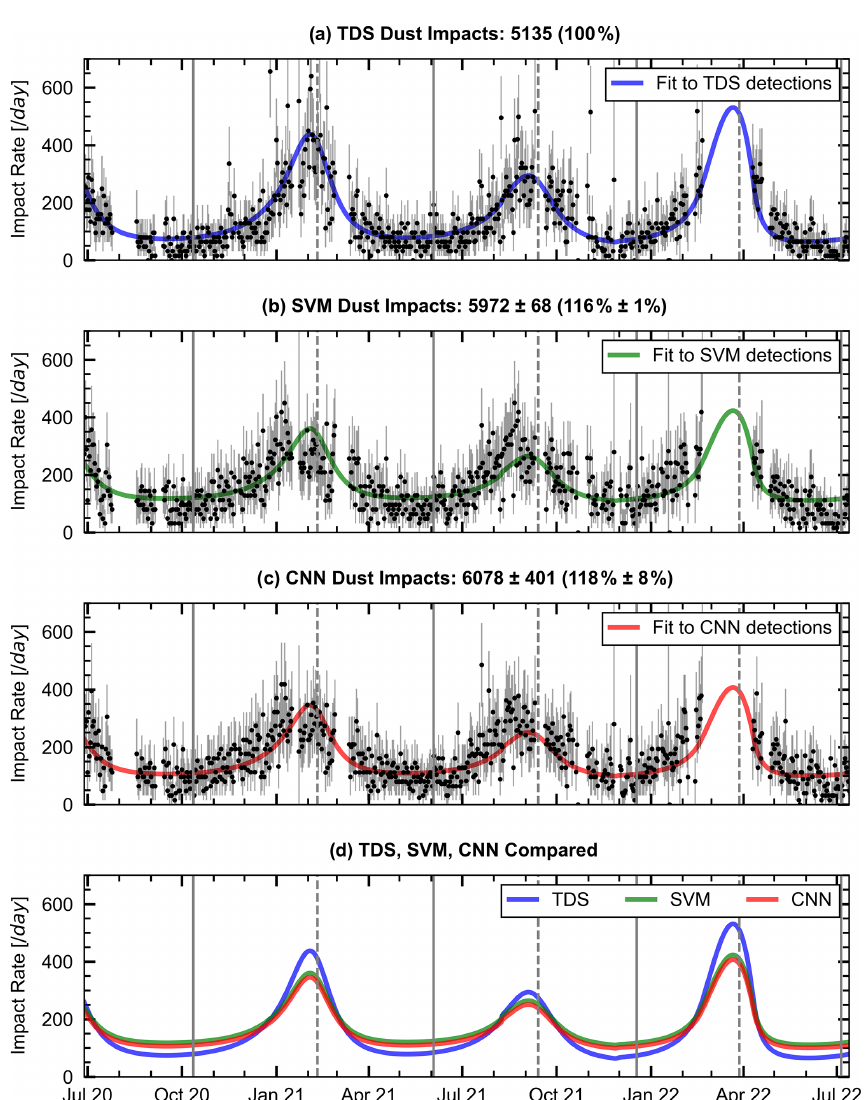
Figure 11. (a) The daily dust impact rates according to the TDS classifier. The full vertical lines indicate times when the Solar Orbiter is at aphelion, while the dashed lines indicate times at perihelion. (b) The median of the daily impact rates classified by 10 trained SVM classifiers. (c) The median of the daily impact rates from the 10 CNN classifiers. The impact rate function curves are obtained by fitting the dust flux model from Zaslavsky et al. (2021), Eq. (7). (d) The impact rate function cures are compared. The SVM and CNN dust impact rates are very similar, whereas the TDS provides notably smaller impact rates at aphelion and higher impact rates at perihelion. The accumulated dust impact detections for the TDS classification algorithm and the mean and standard deviation of the dust impact detections for the 10 CNN and SVM classifiers are presented in the subplot titles. Note that the large data gap around April 2022 (perihelion 3) is due to a different observational setup for the Solar Orbiter RPW–TDS system, where the sampling frequency was doubled. These data were excluded since it can not be reliably classified by the SVM/CNN methods without additional data processing and/or